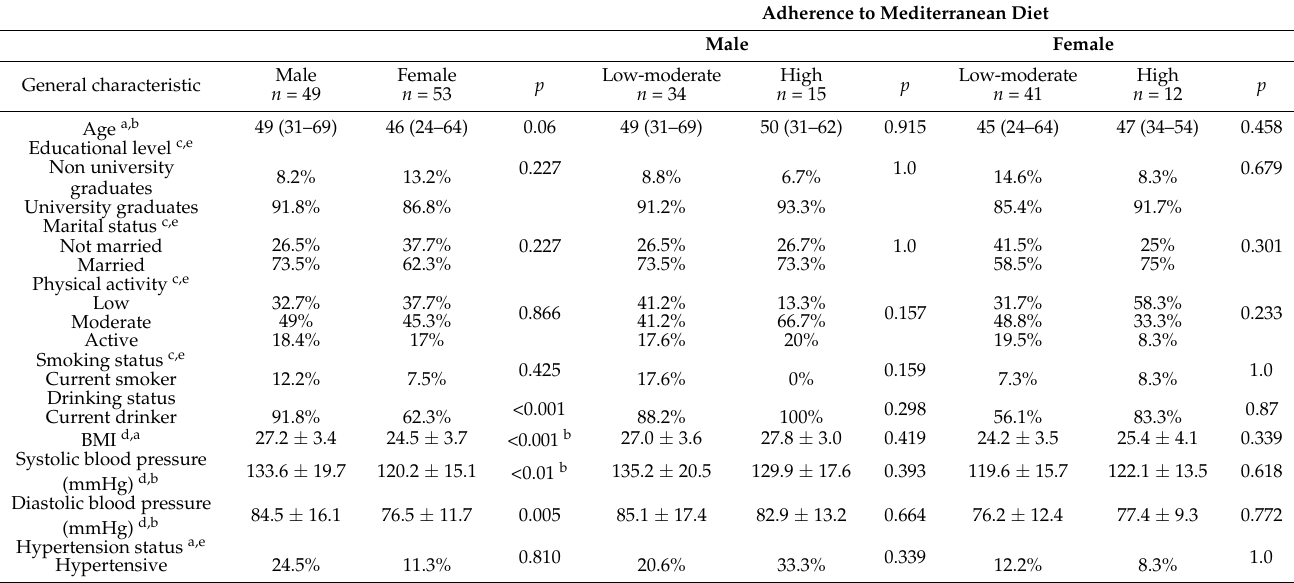
Table 1. General characteristics of participants according to sex and adherence to a Mediterranean diet. Adherence to Mediterranean Diet Male